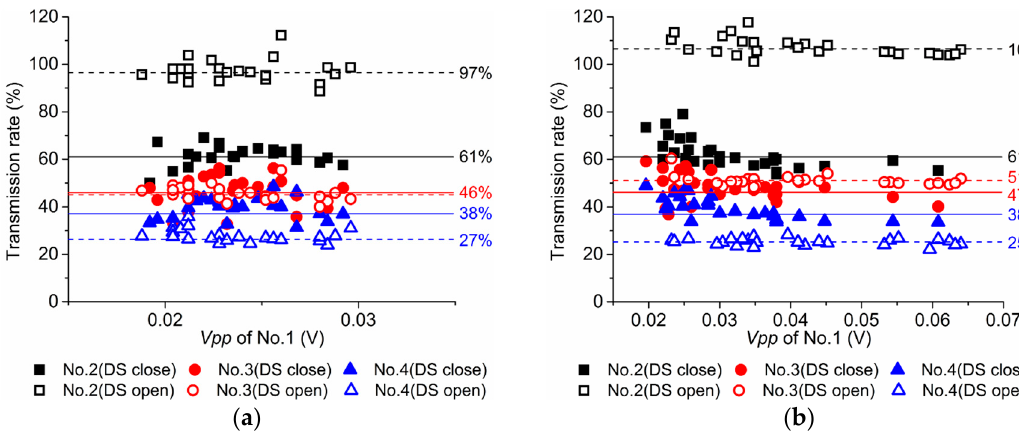
Figure 11. The transmission rates of UHF signals on θ = 180°. ( a ) U = 6.5 kV; ( b ) U = 9.6 kV.